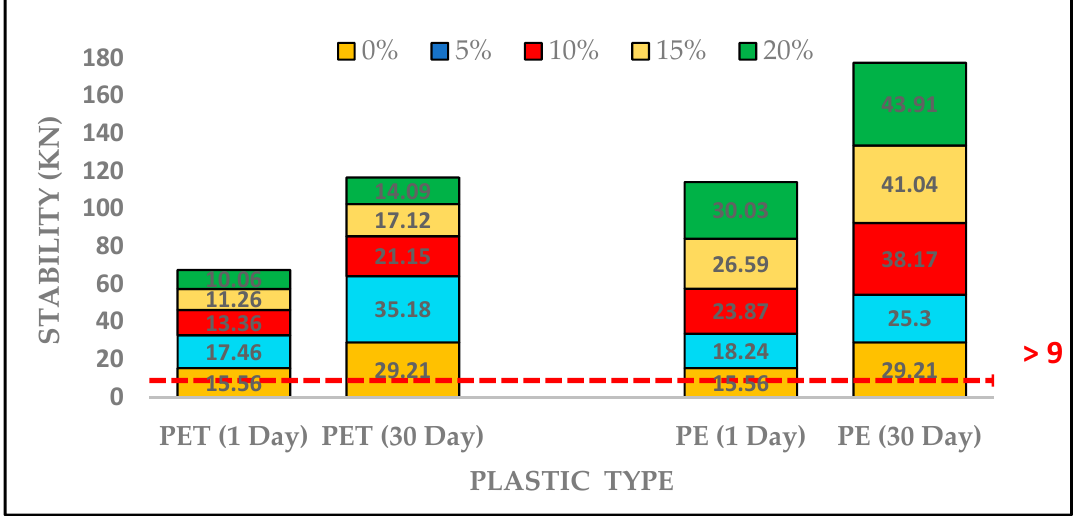
Figure 9. Stability of Plastic-Modified asphalt concrete under different testing days .